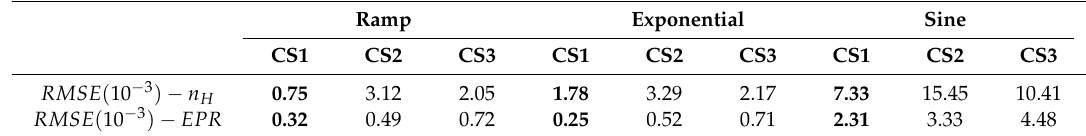
Table 2. RMSE of responses of different